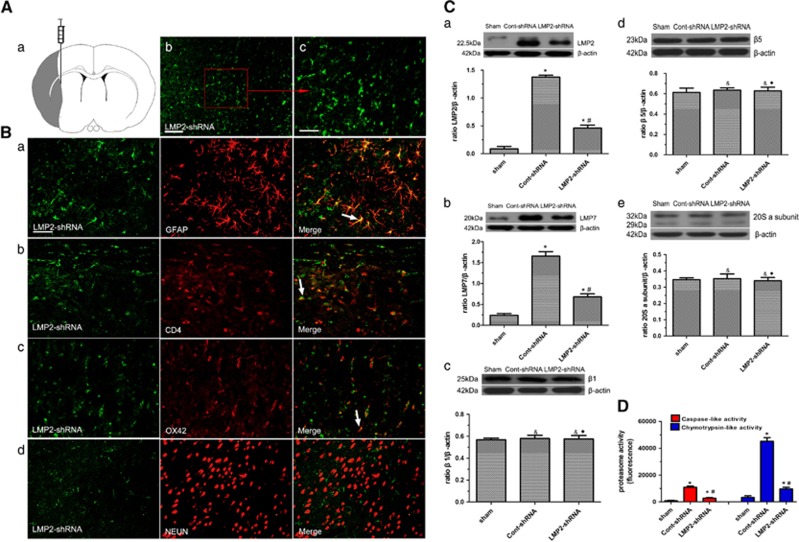
LMP2 knockdown by shRNA and immunoproteasome expression as well as proteasome activity in the brain after MCAO. (A) Schematic diagram of brain section showing the location of cortical and striatum infarction (black color) and where lentivirus was injected (a). EGFP-tagged shRNA was detected in the cortical and the striatum at 72 h after MCAO (b and c). (B) Immunofluorescence labeling showed that EGFP-tagged LMP2-shRNA was expressed in GFAP+, CD4+T lymphocytes and OX42 +cells not in NEUN-positive neurons (arrow) (a–d). Five rats in each group were used for immunofluorescent assays (n=5). (C) Western blot results demonstrated that LMP2 knockdown markedly decreased the protein levels of LMP2 and LMP7 compared with cont-shRNA group. Five rats in each group were used for western blot (n=5). (D) MCAO induced a robust increase in C-L and CT-L activities compared with the sham-operated controls, whereas LMP2-shRNA led to decreased in C-L and CT-L activities compared with cont-shRNA group, respectively (*P<0.001, &P>0.10, compared with the sham-operated controls; #P<0.001, ♦P>0.10, compared with the cont-shRNA group) (figure 5). Scale bars=80 μm (in A: b), 50 μm (in A: c, B)